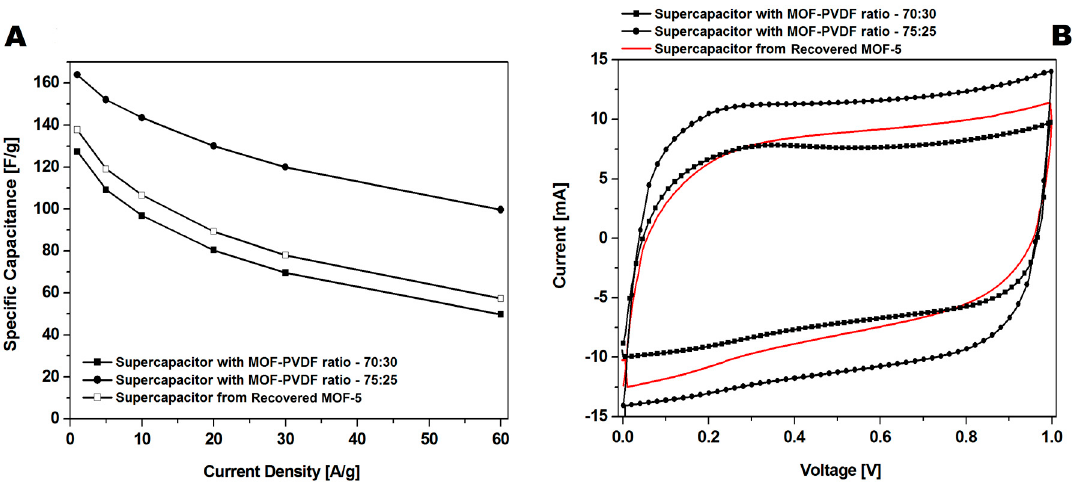
Figure 13. The comparison of the GCD ( A ) and CV ( B ) curves at a 200 mV/s scan rate of supercapacitors made of recovered MOF (additionally purified MOF: r2-CMOF-5) and pristine carbonized MOF (at a ratio of 75:25 and 70:30).